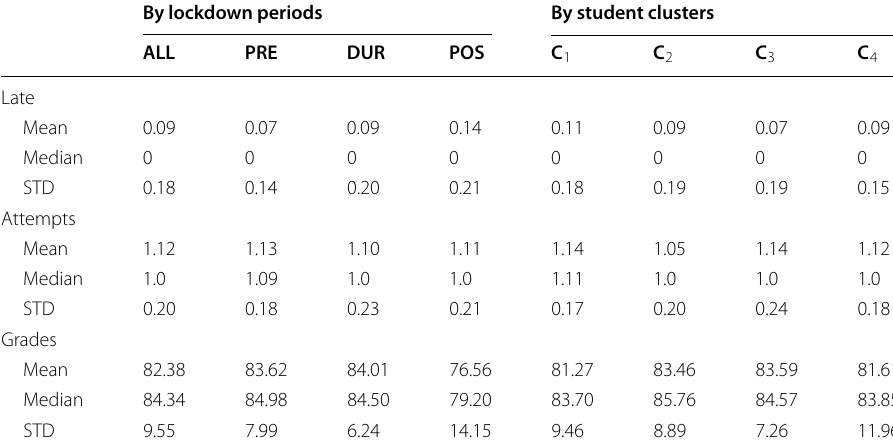
Table 6 Statistics of academic metrics By lockdown periods By student clusters